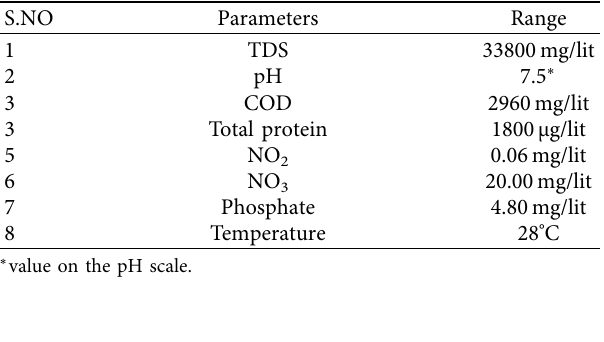
Table 3: Characteristics of the soak effluent.